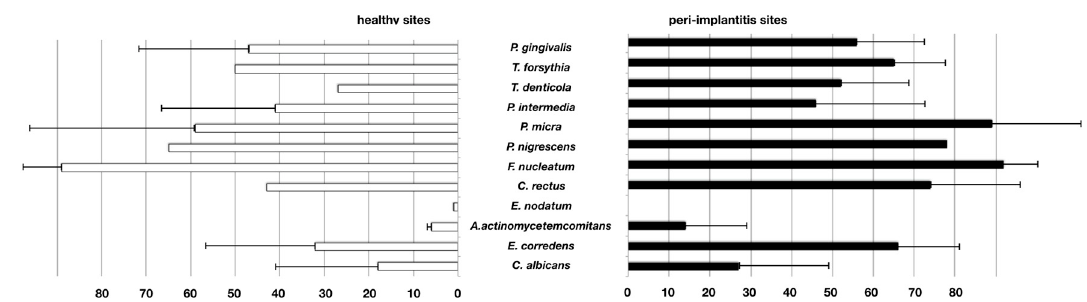
Figure 7. Frequency of positive detection in studies performing PCR-based assessment. Weighted percentages of positive assessment in samples from healthy and peri-implantitis sites (bars = means, whiskers = standard deviation).